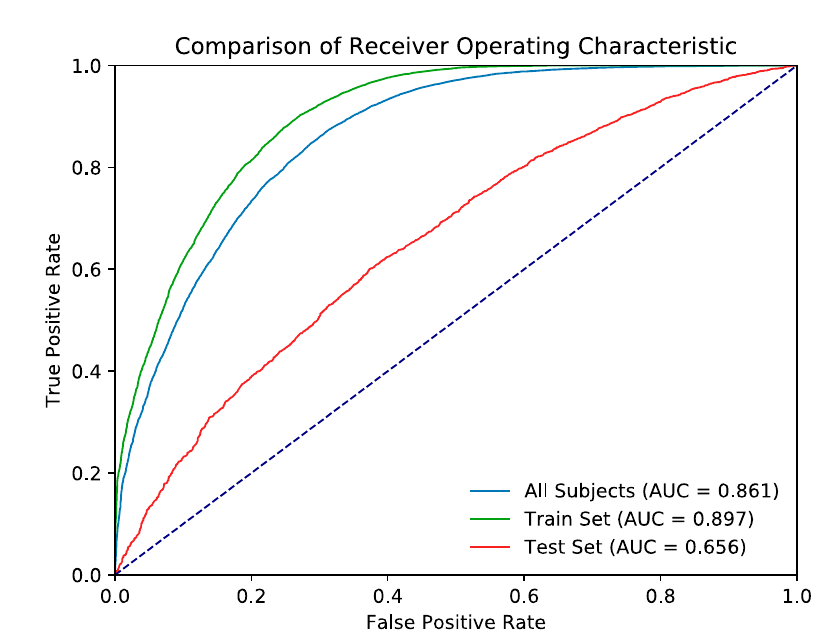
Figure 4. Presents the receiver operating curve (ROC) of the evaluation metrics of the random forest classification classification model.